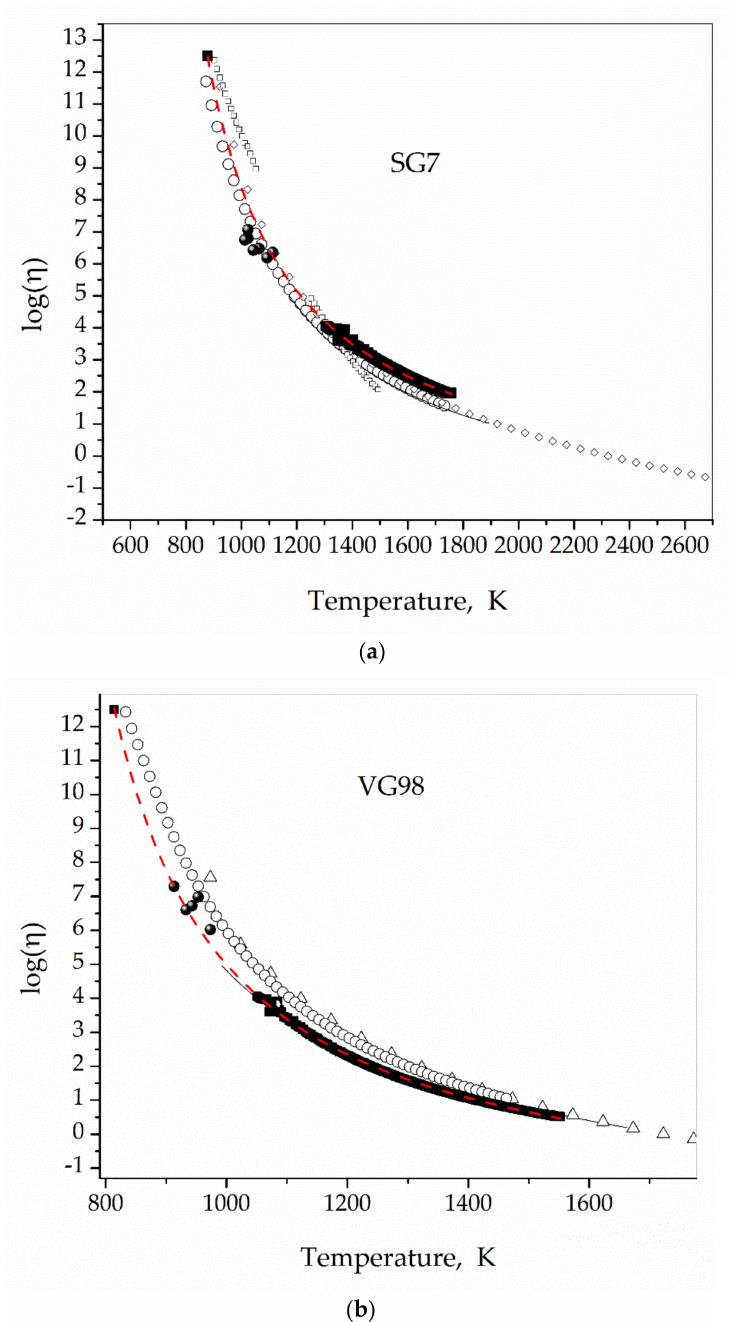
Figure 11. Assigned viscosity values for SG7 ( a ) and VG98 ( b ) glasses (solid spheres), measured with the rotating concentric cylinders technique (solid black squares), VFT fit to measured values and η ( T g ) = 10 12.5 Pa s (Red dashed lines), theoretical values calculated using SciGlass 7.9 (hollow circles, squares, triangles, and diamonds). Viscosity in Pa